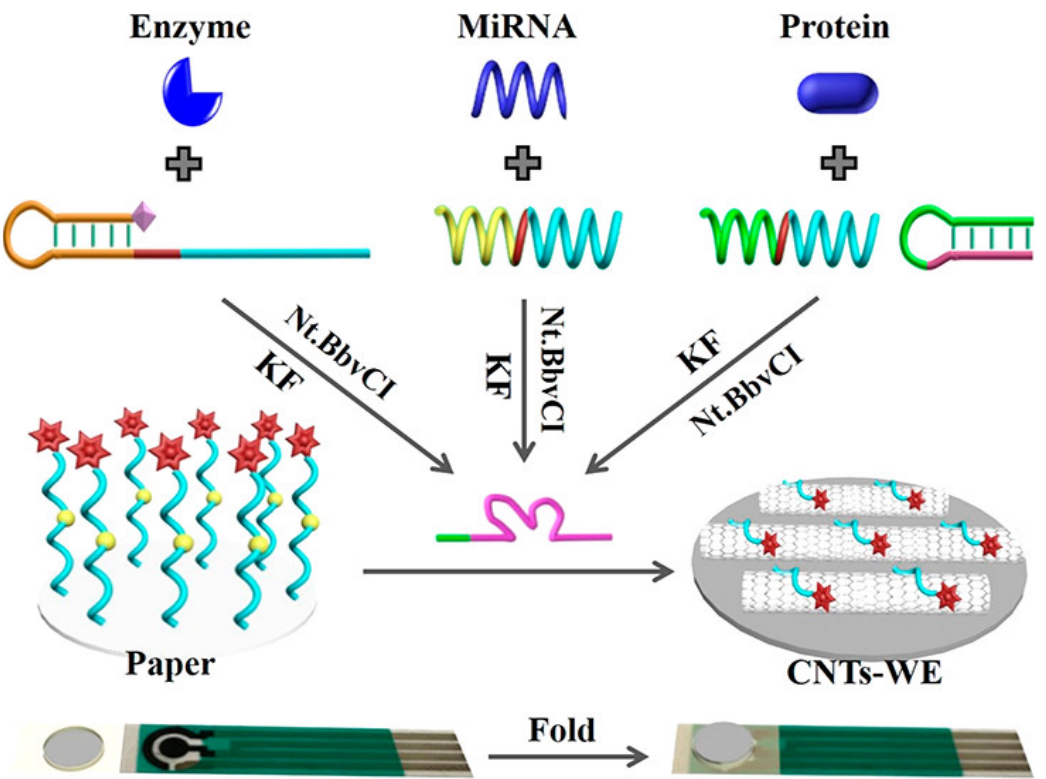
Figure 7. Schematic representation of a universal paper-based electrochemical sensor system that uses a paper modified with signal molecule-labeled DNA and a screen-printed electrode. Reproduced with the permission of [115]. Copyright 2019, American Chemical Society.